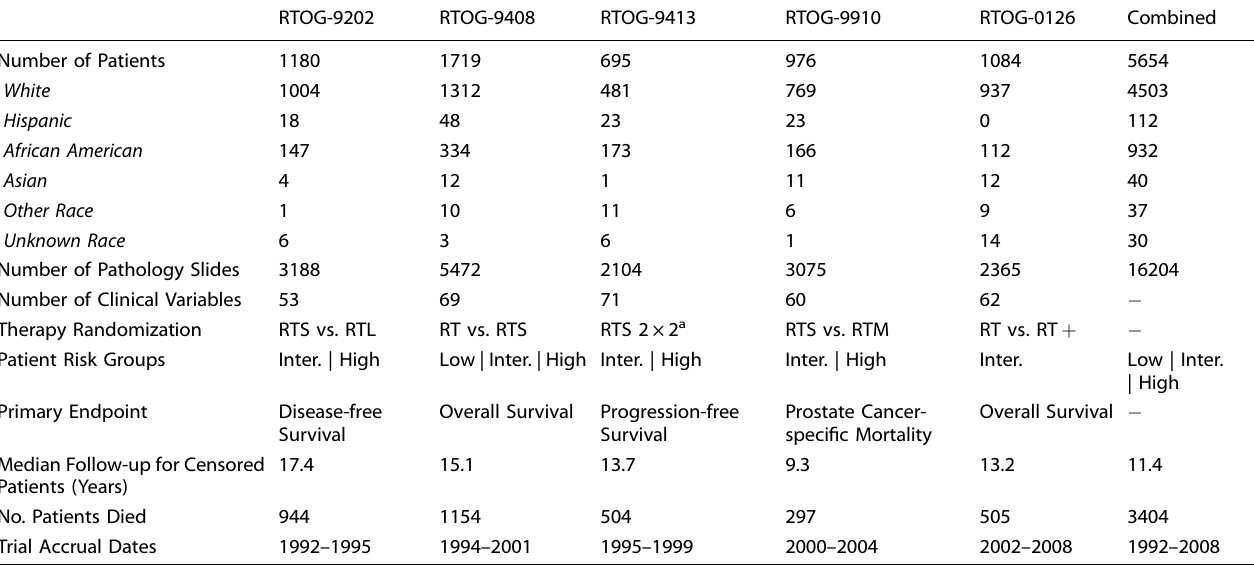
Table 1. Clinicopathologic and trial